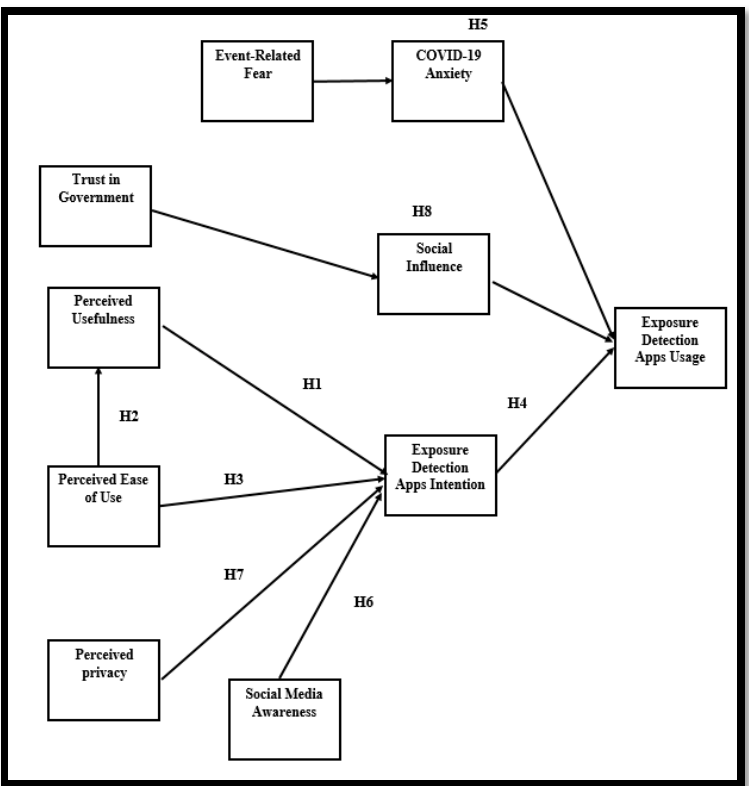
Figure 1. Research Figure 1. Research framework.